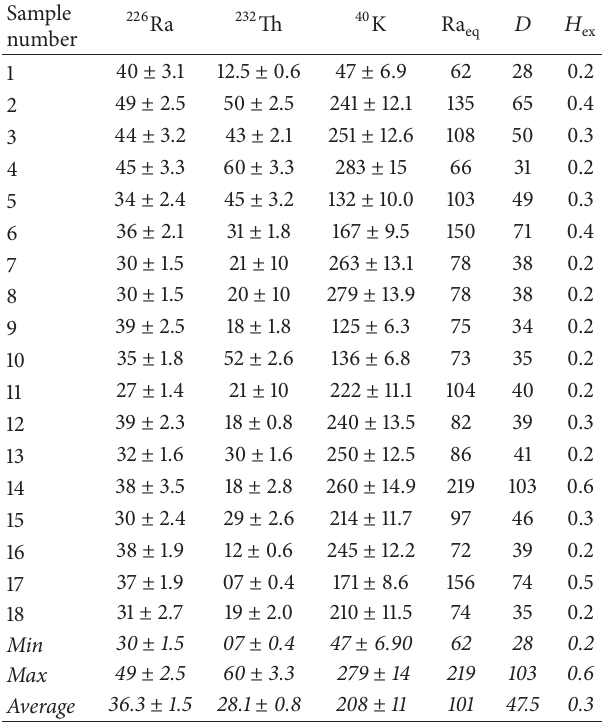
Table 3: Specific activities and radiological indices for the clay studied